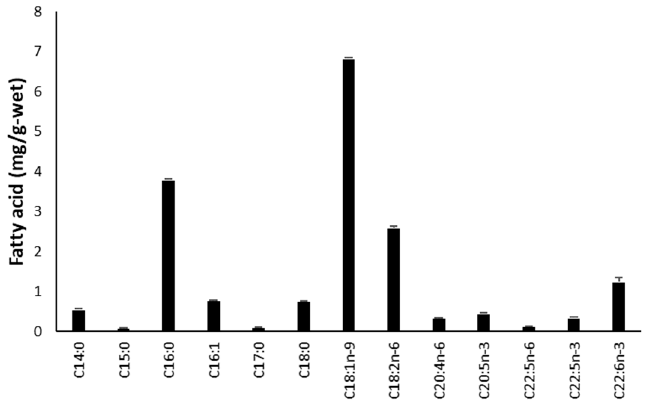
Figure 1. The percentage of each fatty acid compared with the total fatty acid. Values are mean ( n = 3).